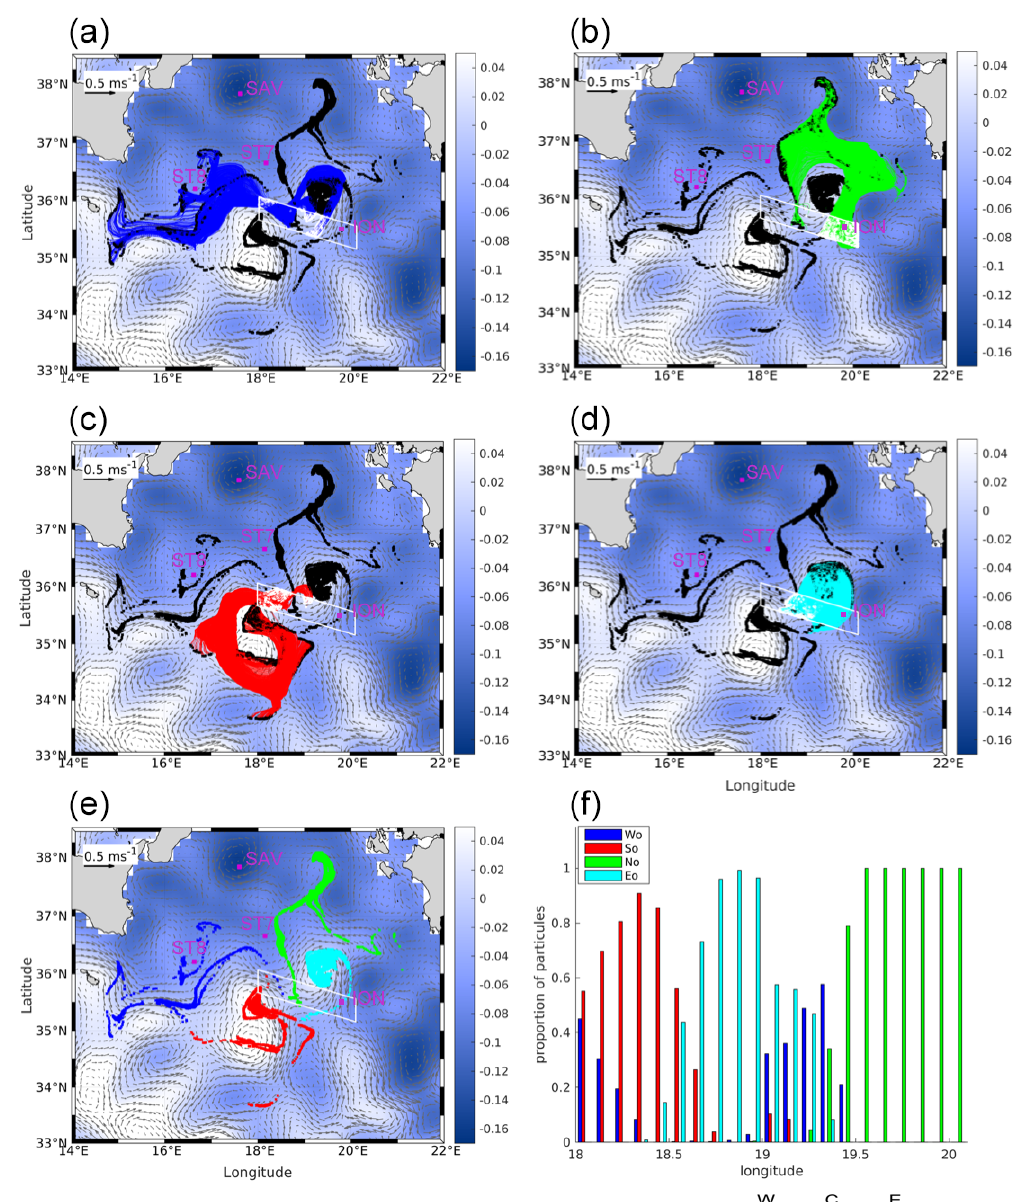
Figure 8. Backward Lagrangian trajectories for particles launched along ION-Tr and tracked for 1 month, overlaid on average ADT (colors) and surface currents (black vectors) averaged for the period 1–30 May. The particle launch area is indicated by the white polygon. (a– d) Trajectories separated according to the four major origins. (a) Wo, (b) No, (c) So and (d) Eo. Black dots are the particle positions at the end of the backward advection, i.e., 1 month before our sampling. (e) Final positions of particles for each origin. The pink dots are the station positions. (f) Proportion of each origin along ION-Tr computed for each 0.1 ◦ of longitude. The three zones of ION-Tr shown in Fig. 5 are indicated at the